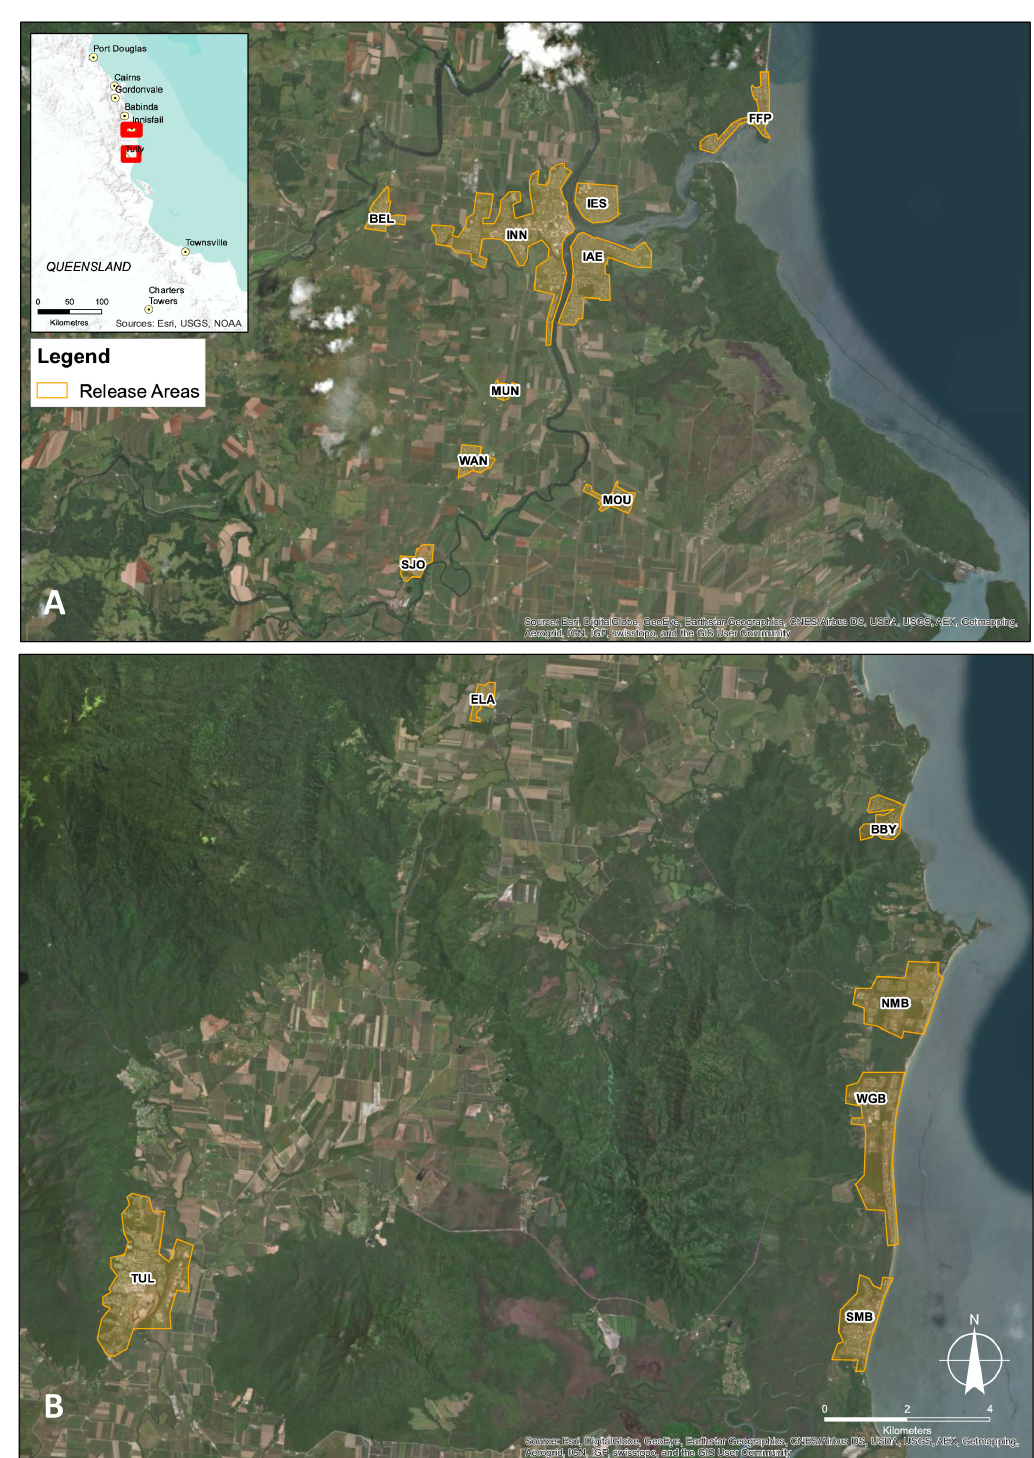
Figure 3. Map of Cassowary Coast - Innisfail release areas. Belvedere (BEL), Innisfail (INN), Innisfail Estate (IES), Flying Fish Point (FFP), Innisfail East (IAE), Mundoo (MUN), Wagan (WAN), Mourilyan (MOU), South Johnstone (SJO) ( A ) and Cassowary Coast – Tully release areas Bingal Bay (BBY), El Arish (ELA), North Mission Beach (NMB), Wongaling Beach (WGB), South Mission Beach (SMB), Tully (TUL) ( B ).